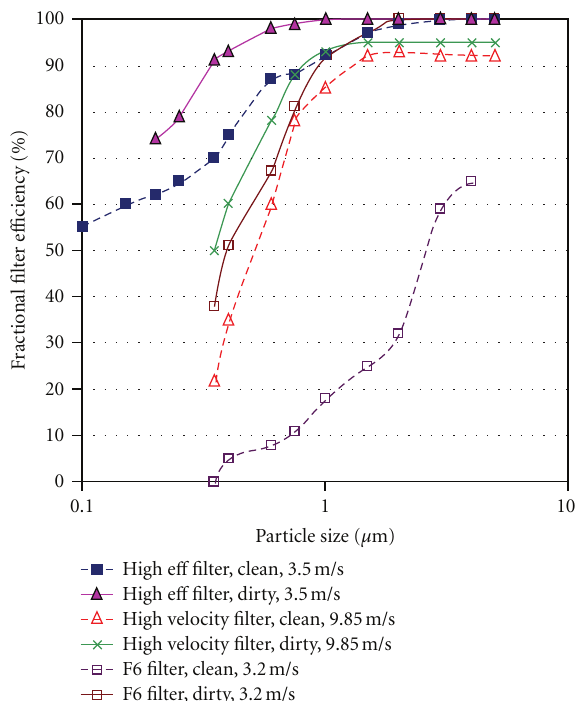
Figure 3: Comparison of fractional e ffi ciency for filter elements from di ff erent suppliers and di ff erent face velocities in new and dirty conditions